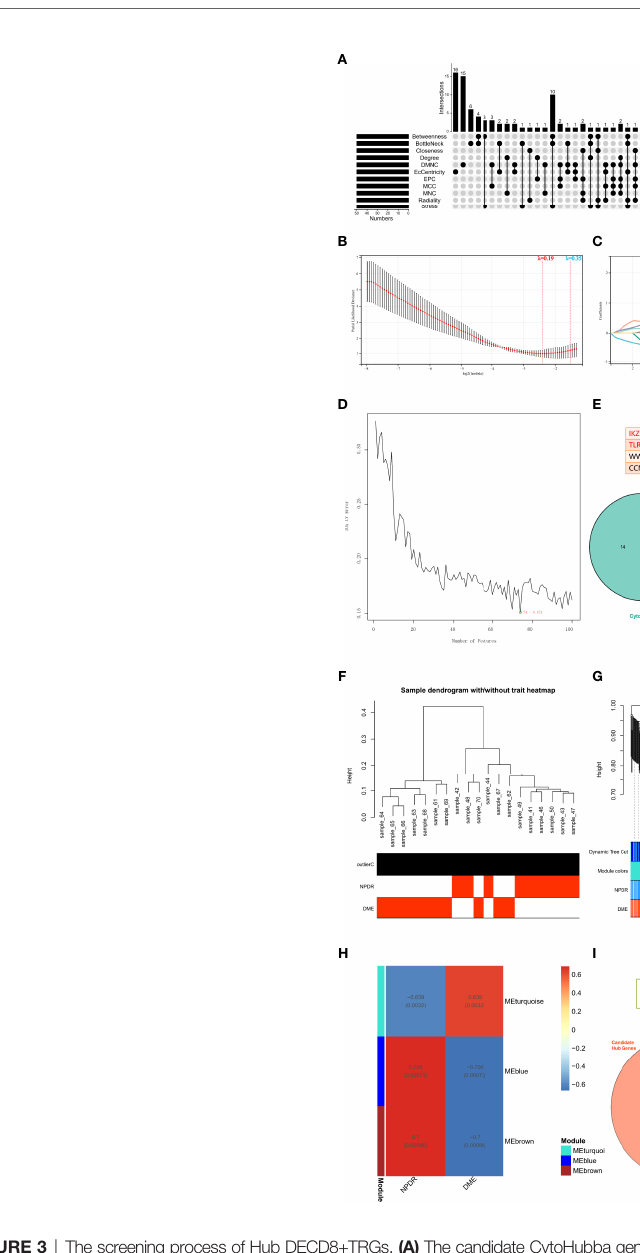
FIGURE 3 | The screening process of Hub DECD8+TRGs. (A) The candidate CytoHubba genes obtained by performing eleven algorithms of the CytoHubba plug-in in Cytoscape software, the genes that meet the conditions of 9 or more algorithms were recognized as candidate CytoHubba genes and were marked in the blue box in the fi gure. (B) The parial likelihood deviance in the jackknife rates analysis. (C) The Lasso coef fi cient distribution plot of DECD8+TRGs, which is used to identify the eigenvalues of the constructed diagnostic signal. Each curve corresponds to a candidate gene. (D) SVM-RFE algorithm identi fi es the candidate DECD8+TRGs with the lowest error rate and the highest accuracy (10 × CV error rate = 74 -0.151). (E) The Venn plot illustrates the candidate hub genes obtained after the comprehensive intersection of CytoHubba, Lasso regression and SVM-RFE. (F) Clustering the samples and checking the outliers. Both NPDR and DME samples were included in the cluster and unsupervised clustering was performed, neither NPDR nor DME sample contained outliers. (G) The coexpression gene clusters were analyzed by dynamic tree cutting method, and the modules with high similarity were merged. The hierarchical clustering dendrogram illustrated that there were three co-expression modules, which were MEturquoise, MEblue and MEbrown. (H) Clinical feature-related gene module heat map, showing the clinical phenotypic correlation of each co-expressed module gene cluster. (I) The Venn diagram shows the genes obtained by the intersection of the candidate hub genes in fi gure E and the turquoise module genes of WGCNA, in which the core genes are identi fi ed by the MCODE plug-in in Cytoscape software and de fi ned as Hub